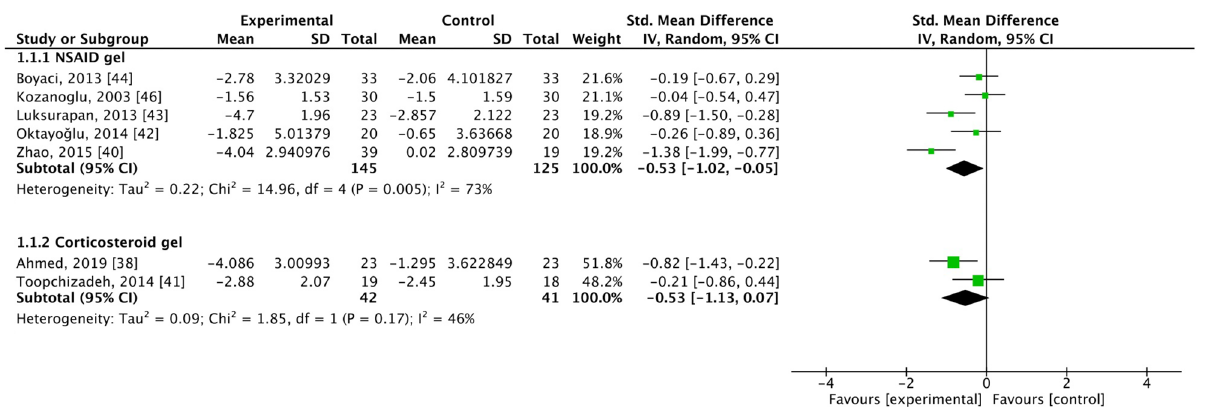
Figure 3. Forest plot for changes from baseline determined using the pain scores. SD, standard deviation; CI, confidence